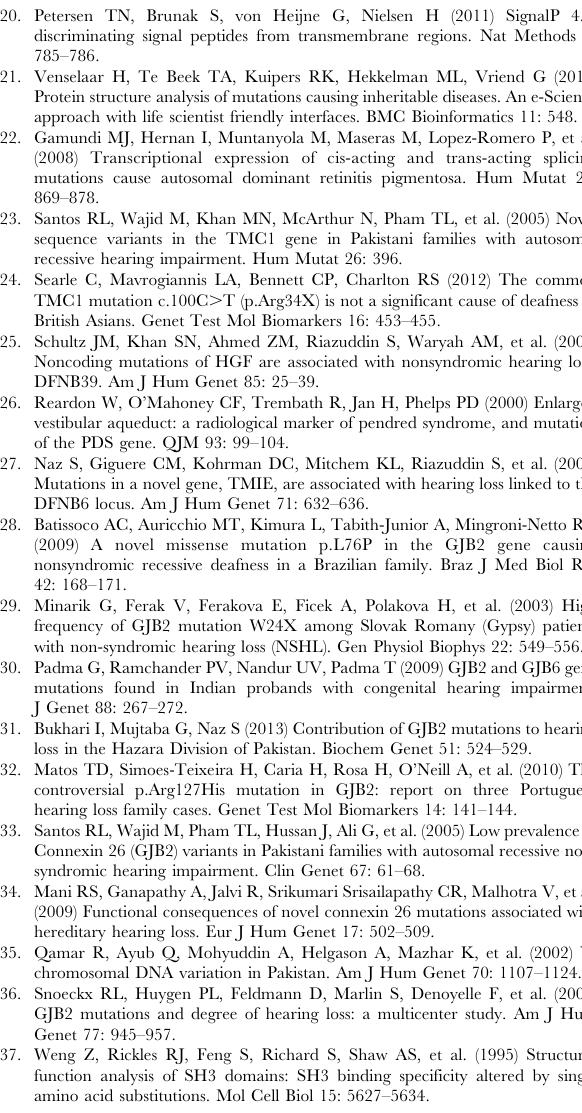
Table S1 Characteristics of 30 Pakistani families diagnosed with autosomal recessive non-syndromic hearing loss